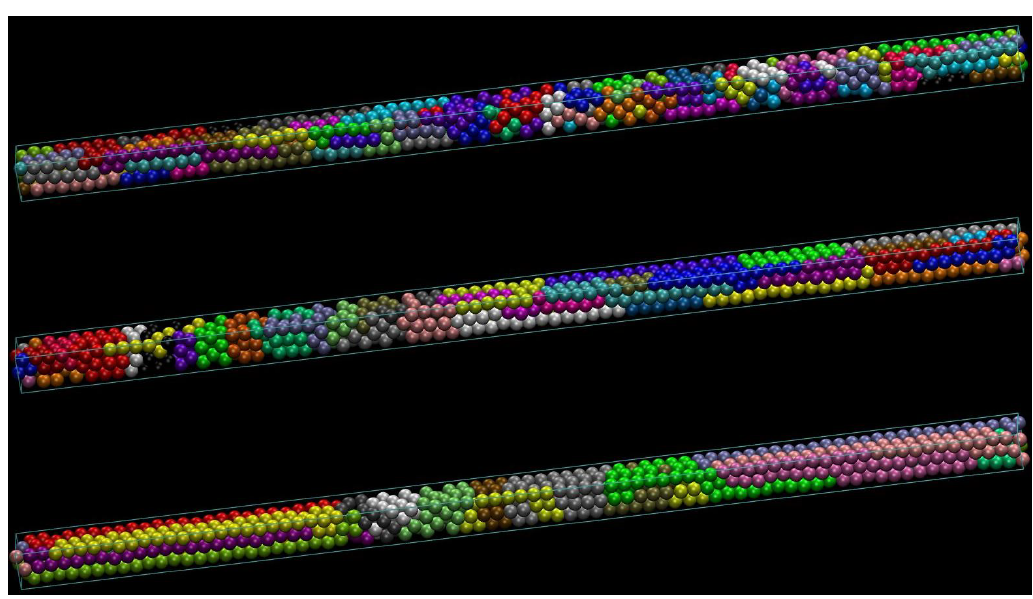
Figure 1. Lateral views of computer-generated, linear freely jointed chains of tangent hard spheres of uniform size confined in tubes of square cross section at ϕ = 0.50. All systems contain a total of 720 monomers. From top to bottom: chains consist, on average, of N = 7, 17 and 35 bonds. In all cases, chains are packed in an approximately 3.11 × 3.11 square tube of length 77.8. Periodic boundary conditions are applied on the long dimension and impenetrable flat walls in the short ones. Ordered regions with crystalline defects can easily be recognized by visual inspection. A precise analysis shows them to be slightly defective, coexisting face-centered cubic (FCC) crystals of different orientations. Monomers have been colored according to the chain they belong to. The tube axis direction in both panels is along a direction of the crystallographic type (cid:104) 100 (cid:105) . Image created with the VMD software (version 1.9.3, Theoretical and Computational Biophysics Group, University of Illinois, Urbana, IL, USA) [68].